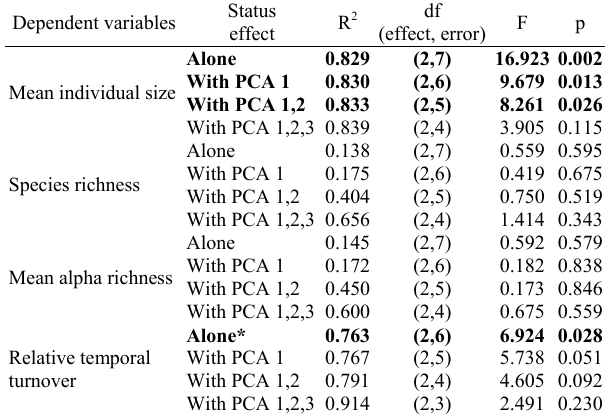
Table 3. Results from ANOVAs/ANCOVAs with four dependent variables. Only the statistics concerning the